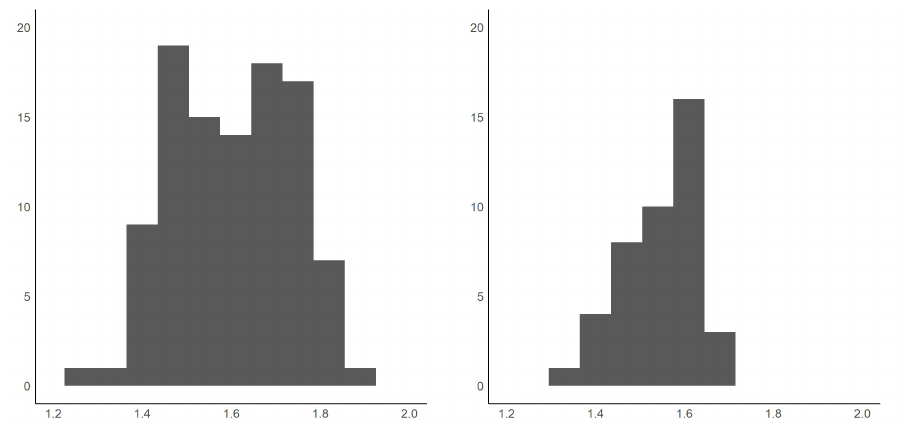
Figure 3. Histogram plots of the per-capita prescriptions for the pre-intervention period (left plot) and the post-intervention period (right plot).